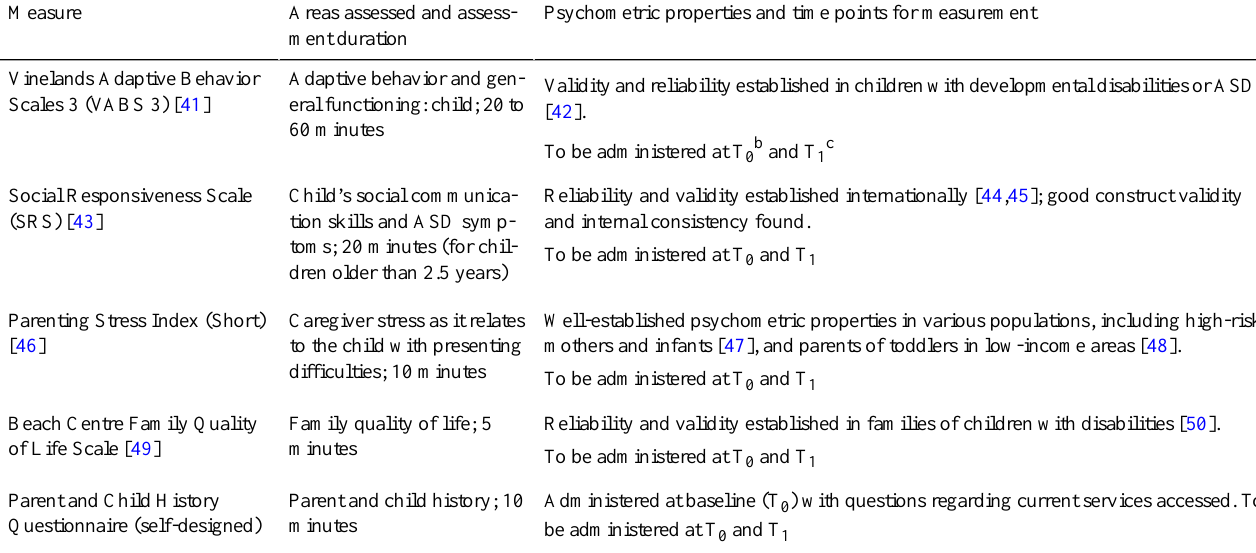
Table 2. Secondary preliminary efficacy measures. Psychometric properties and time points for measurementAreas assessed and assess- durationMeasure ment Validity and reliability established in children with developmental disabilities or ASD